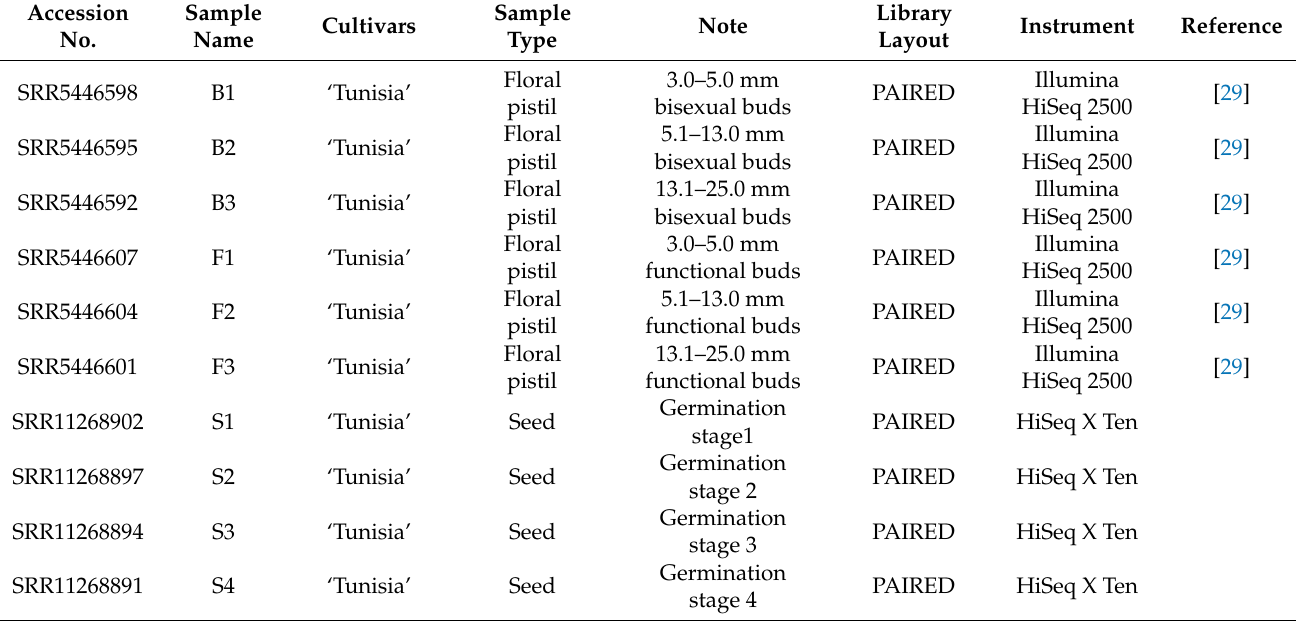
Table 1. Information of RNA-Seq data in